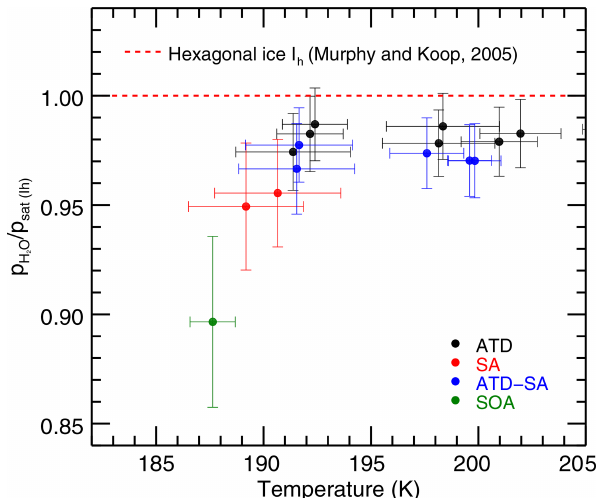
Figure 6. Zoomed in view of the experiments below 205K. Linestrength errors result in the same shift for all experiments, so they are not included in the error bars here. Experiments containing sulfuric acid are ∼ 2 . 6% lower on average than those containing pure ATD experiments. Experiments are colored by aerosol/IN type and MK saturation line is included for